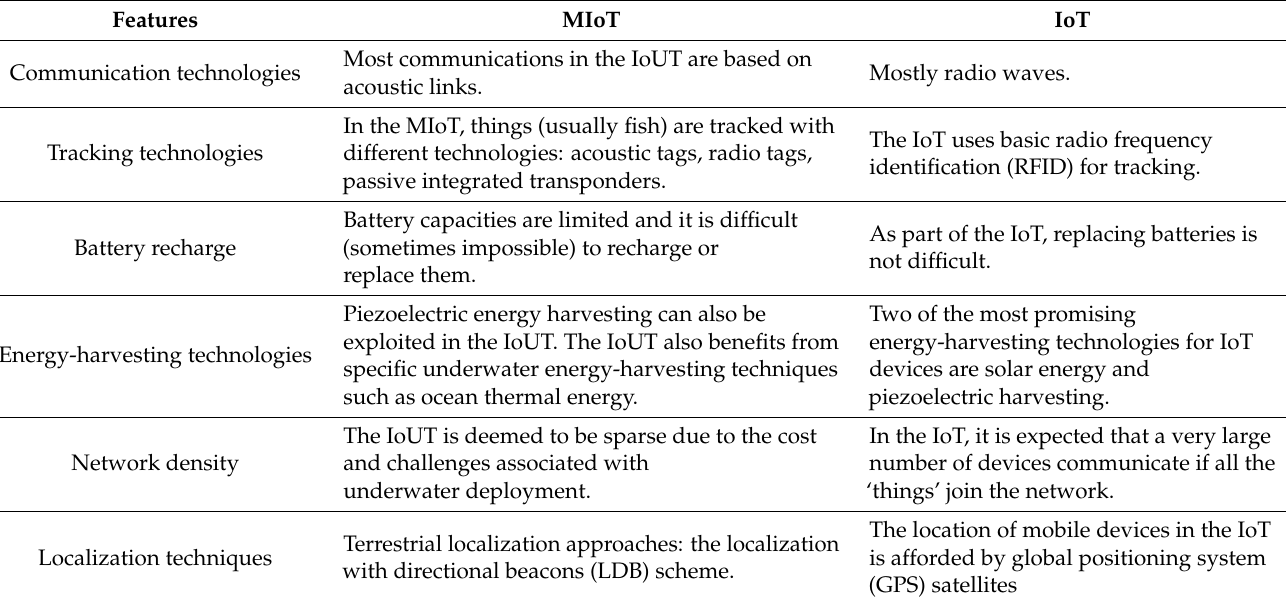
Table 2. Features and differences of MIoT from